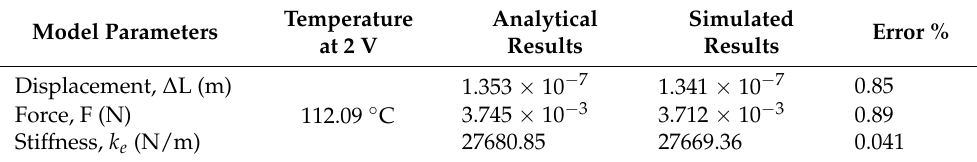
Table 4. Parameter results for the microactuator of two beams.